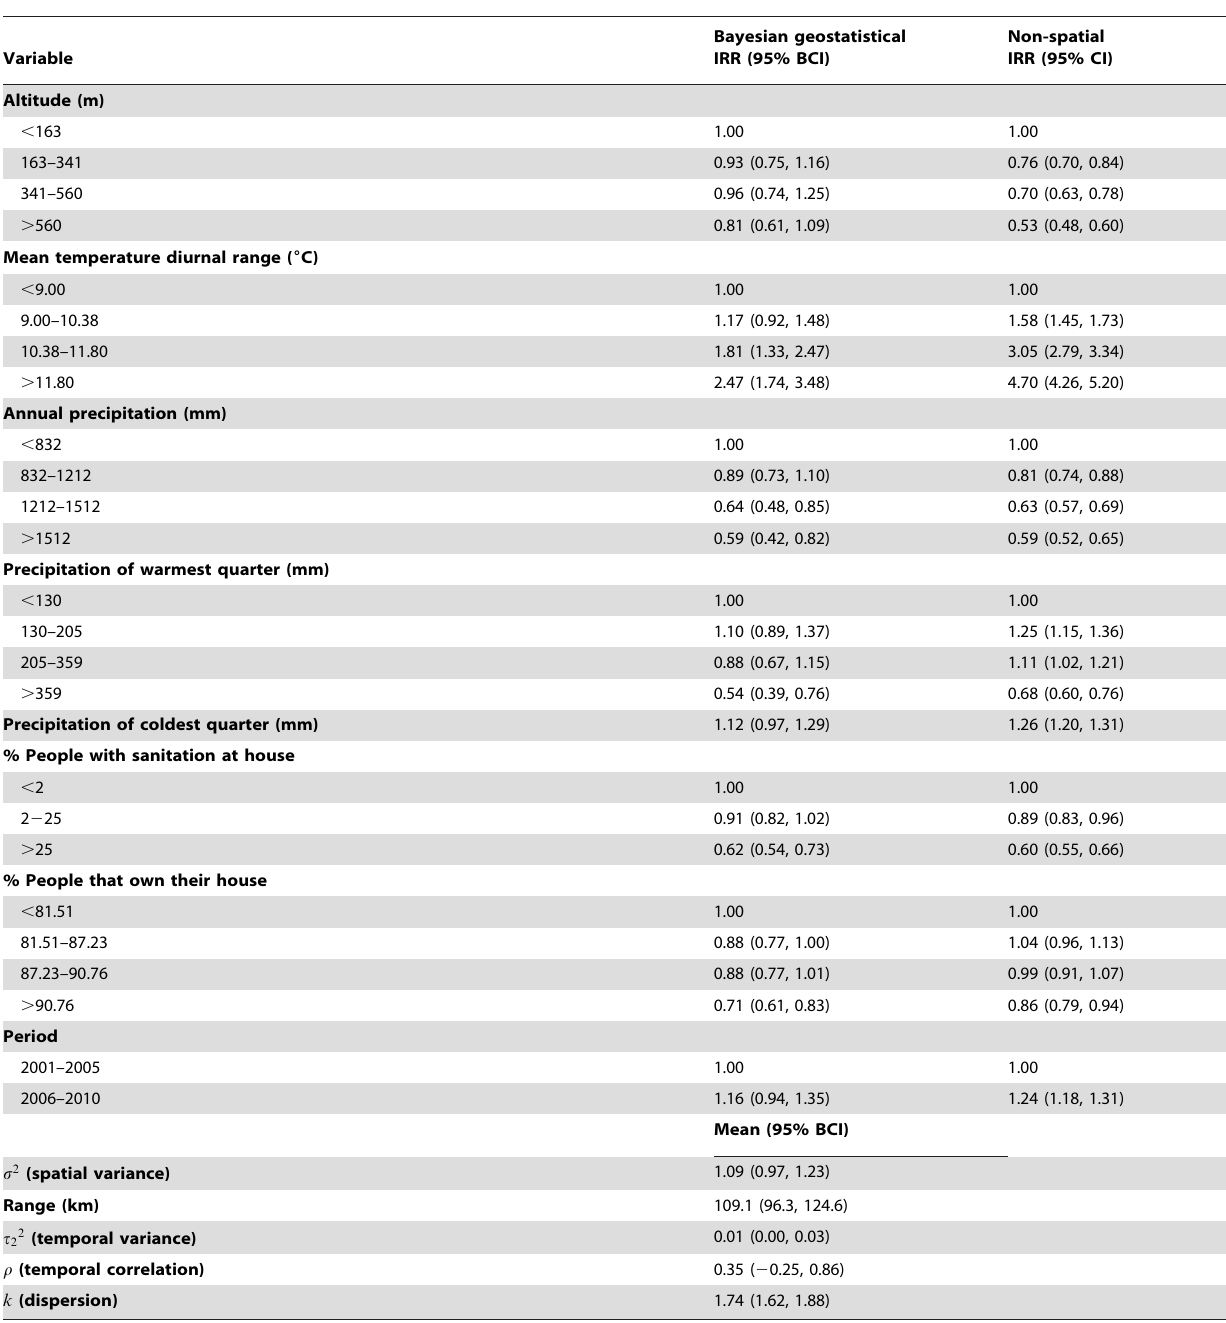
Table 4. Parameter estimates for visceral leishmaniasis (VL) in Brazil for